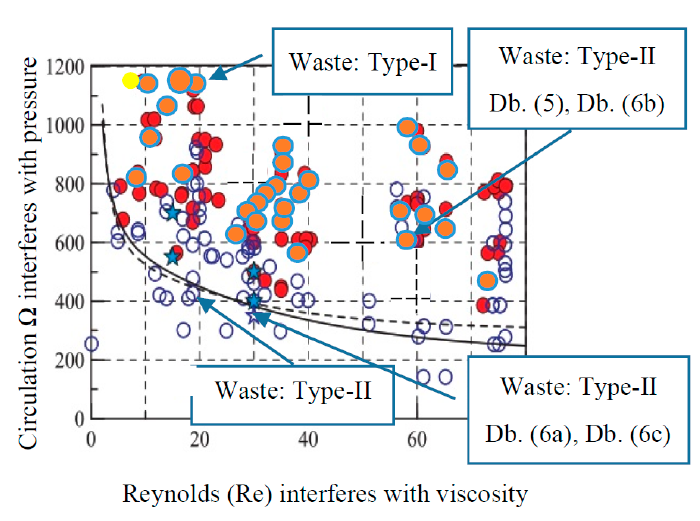
Figure 23. The intersection of significant factors.